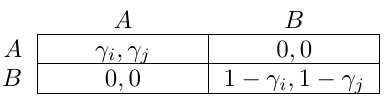
Figure 9. Two player coordination game with heterogeneous preferences. Let γ i , γ j each combination of A and B , entries give payoffs for the row player and column player